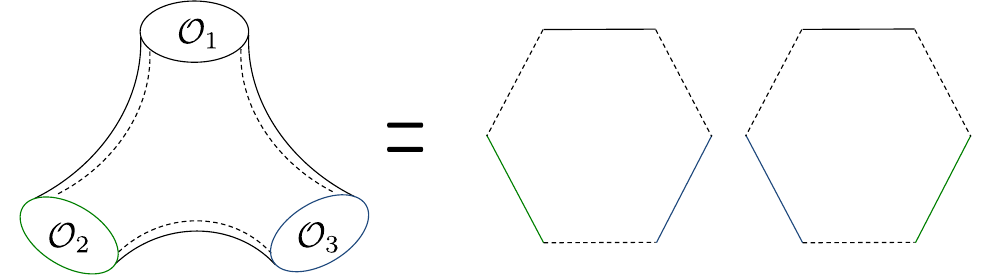
Figure 1 . Hexagonalization of a three-point function of single-trace operators. The string world- sheet dual to the three-point function has a pair-of-pants topology. The idea of the hexagonalization is to cut the pair of pants into two hexagonal patches and stitch them together by summing over intermediate states living on the dashed